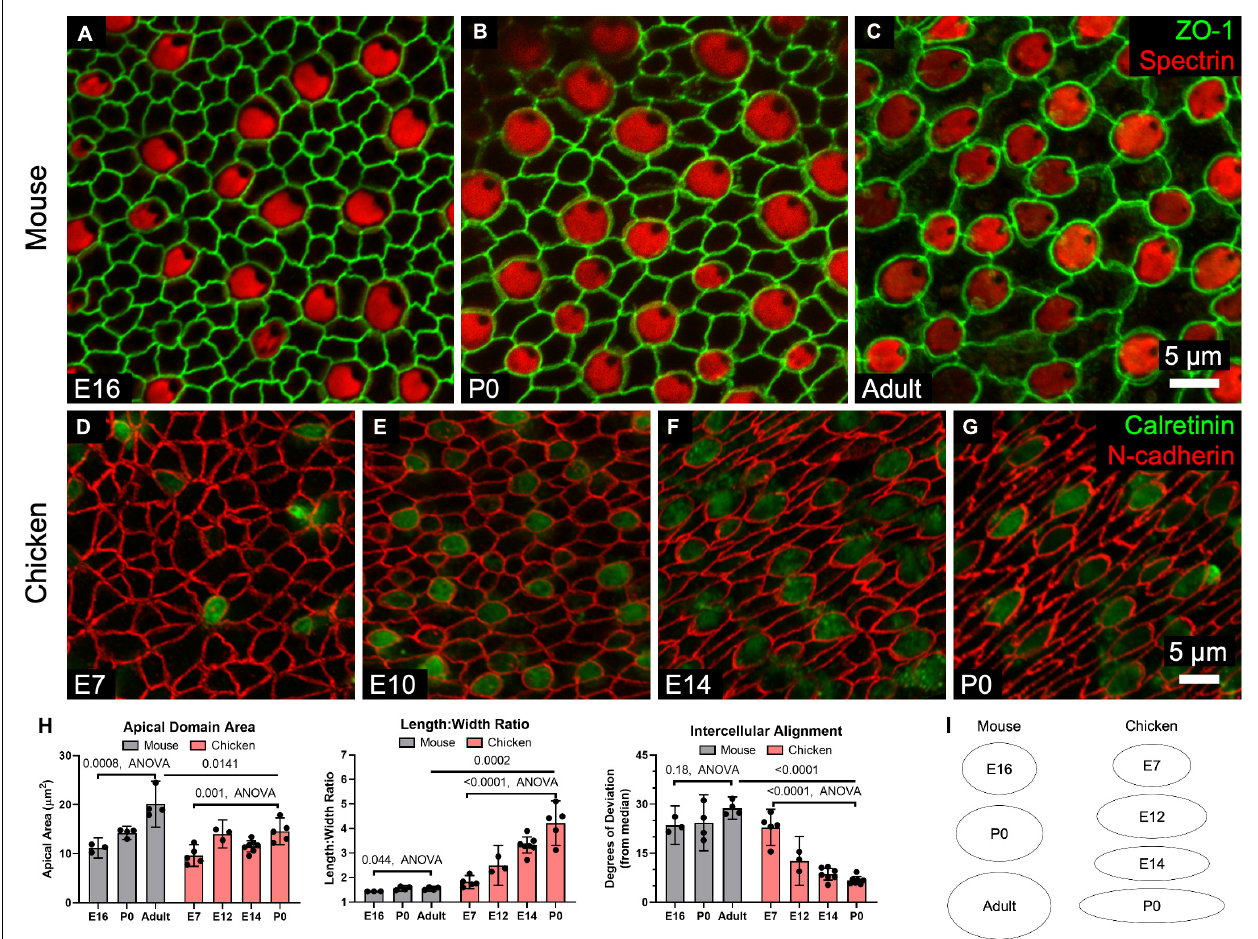
FIGURE 4 | SCs in mouse utricles do not undergo dramatic shape changes during development and postnatal maturation, whereas those in chickens become elongated and locally aligned during development. (A–C) Confocal images of utricles from mice of various ages. Images are from the striolar region. (D–G) Confocal images of utricles from chickens of various ages. (H) Quantification reveals that SC apical domains become significantly larger over time (Mouse: p = 0.0008, F ( 2 , 8 ) = 20.0, ANOVA, n = 3–4 utricles per condition; Chicken: p = 0.001, F ( 3 , 16 ) = 9.05, ANOVA, n = 3–7 utricles per condition). The mean SC area was significantly greater in adult mice than P0 chickens ( p = 0.0141, t ( 7 ) = 3.2, unpaired t -test, n = 4–5 utricles per condition). Both mouse and chicken SCs became significantly more elongated with age (Mouse: p = 0.044, F ( 2 , 8 ) = 4.7, ANOVA, n = 3–4 utricles per condition; Chicken: p = 0.001, F ( 3 , 16 ) = 25.5, ANOVA, n = 3–7 utricles per condition), though elongation was significantly greater in P0 chicken SCs compared to SCs in adult mice ( p = 0.0002, t ( 7 ) = 7.1, unpaired t -test, n = 4–5 utricles per condition). Alignment did not significantly change in mouse SCs with age ( p = 0.18, F ( 2 , 8 ) = 2.1, ANOVA, n = 3–4 utricles per conditions), but significantly increased with age in chicken SCs ( p < 0.0001, F ( 3 , 18 ) = 39.9, ANOVA, n = 3–7 utricles per condition). SCs of the P0 chicken utricle were significantly more aligned than those of adult mouse utricles ( p < 0.0001, t ( 9 ) = 21.9, unpaired t -test, n = 4–7 utricles per condition). (I) The average shapes of SC apical domains in mouse and chicken utricles are depicted as ellipses to denote relative area and length:width ratio.